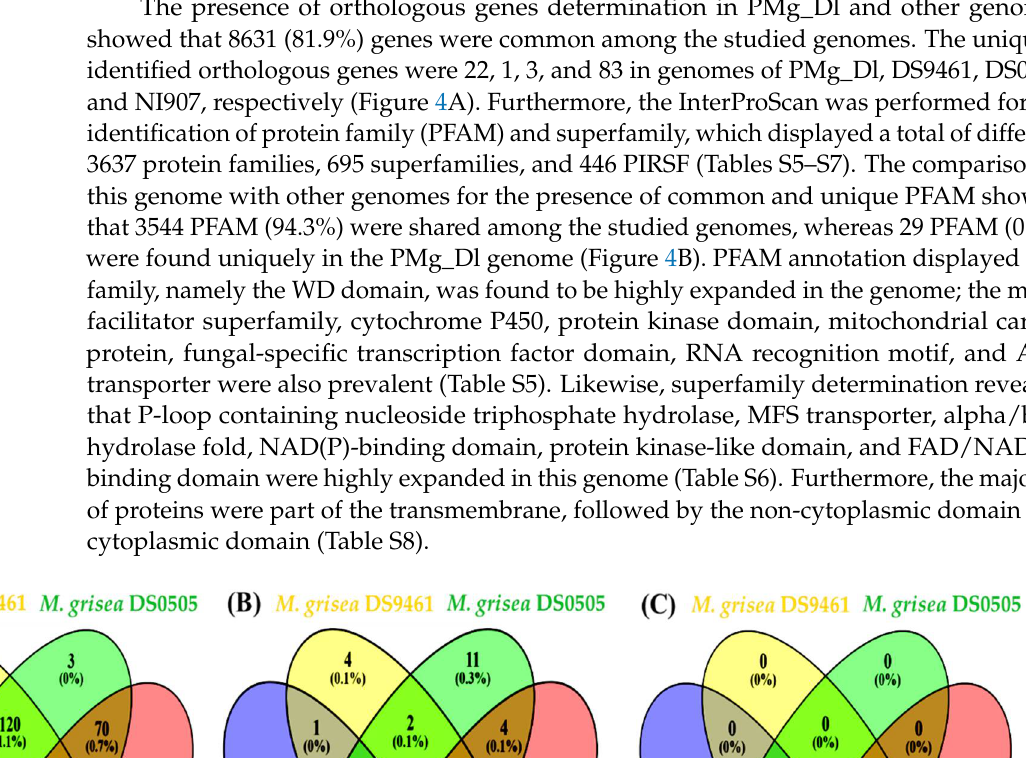
Table 3. Comparative CAZyme family profile in M. grisea PMg_Dl, P. oryzae DS9461, M. oryzae DS0505, and M. oryzae NI907genomes.